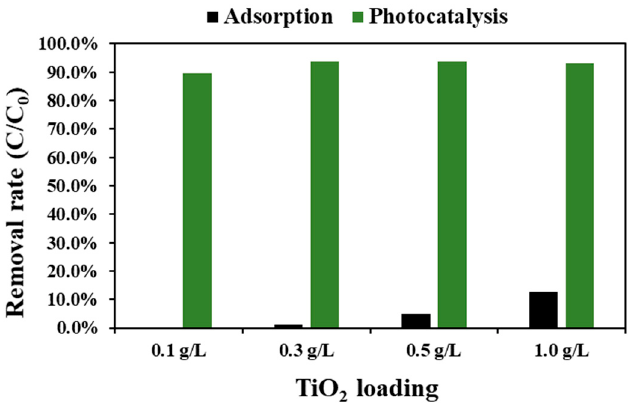
Figure 12. Degradation of selected antibiotics with varied degradation efficiencies at different photocatalyst loadings using UV/TiO 2 photocatalysis for 60 min.